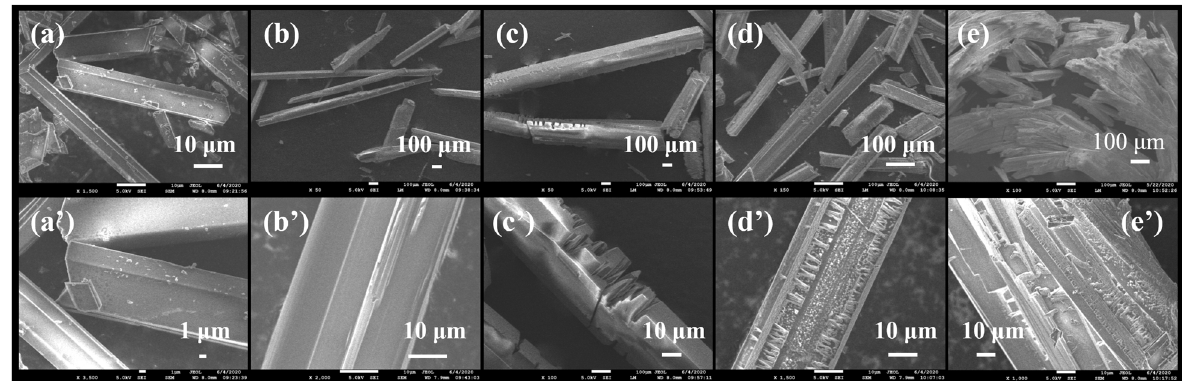
Fig. 5 SEM images of CaSO 4 scale at different magni fi cations. a , a ’ Without antiscalant, b , b ’ with 2 mg/L PASP, c , c ’ with 4 mg/L PASP, d , d ’ with 2 mg/L SiO 2 – NH 2 /PASP, e , e ’ with 4 mg/L SiO 2 – NH 2